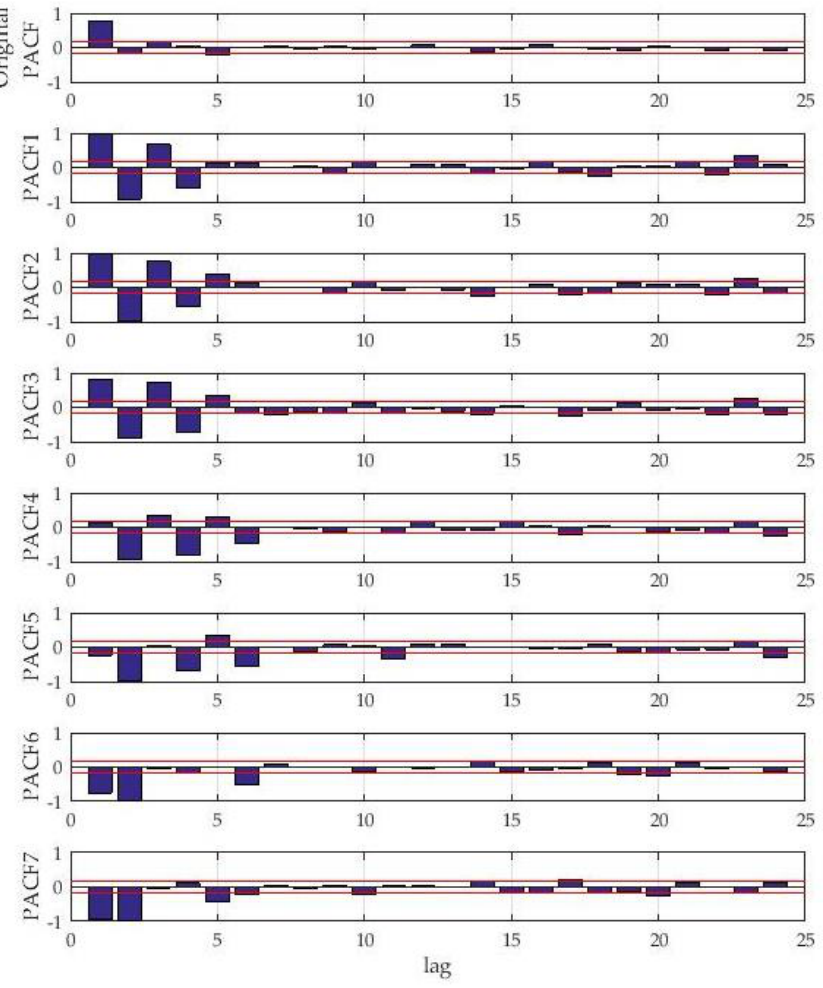
Figure 6. PACFs of the original data and the IMFs extracted from VMD.